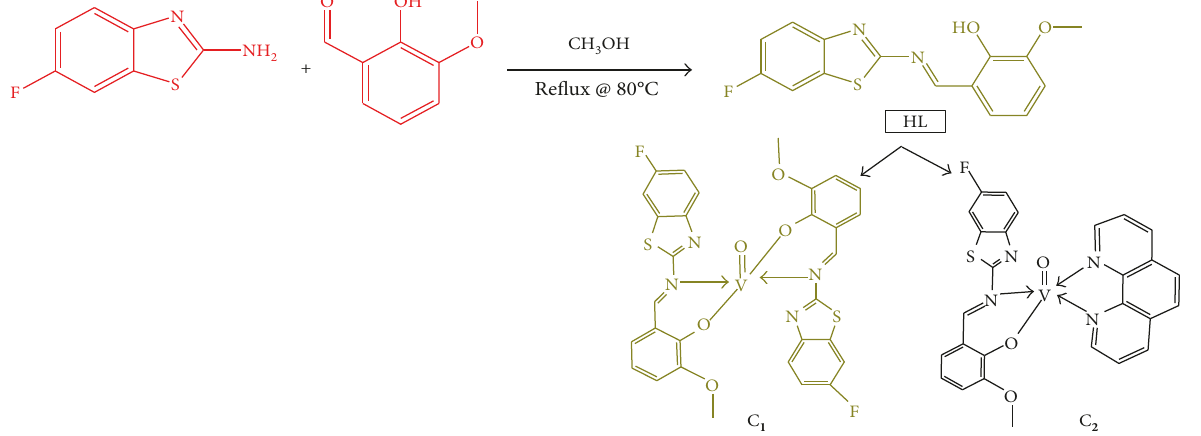
Scheme 1: Synthetic route of ligand HL and its